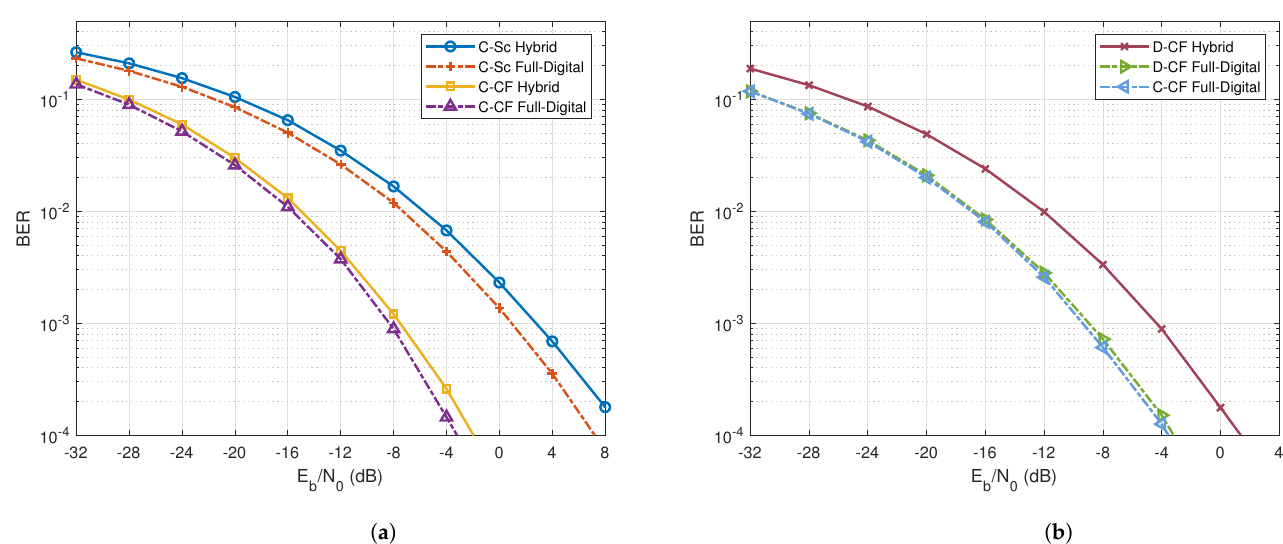
Figure 4. BER performance for ( a ) centralized CF and SC narrow-band-based systems, and ( b ) dis- tributed CF wide-band-based systems.